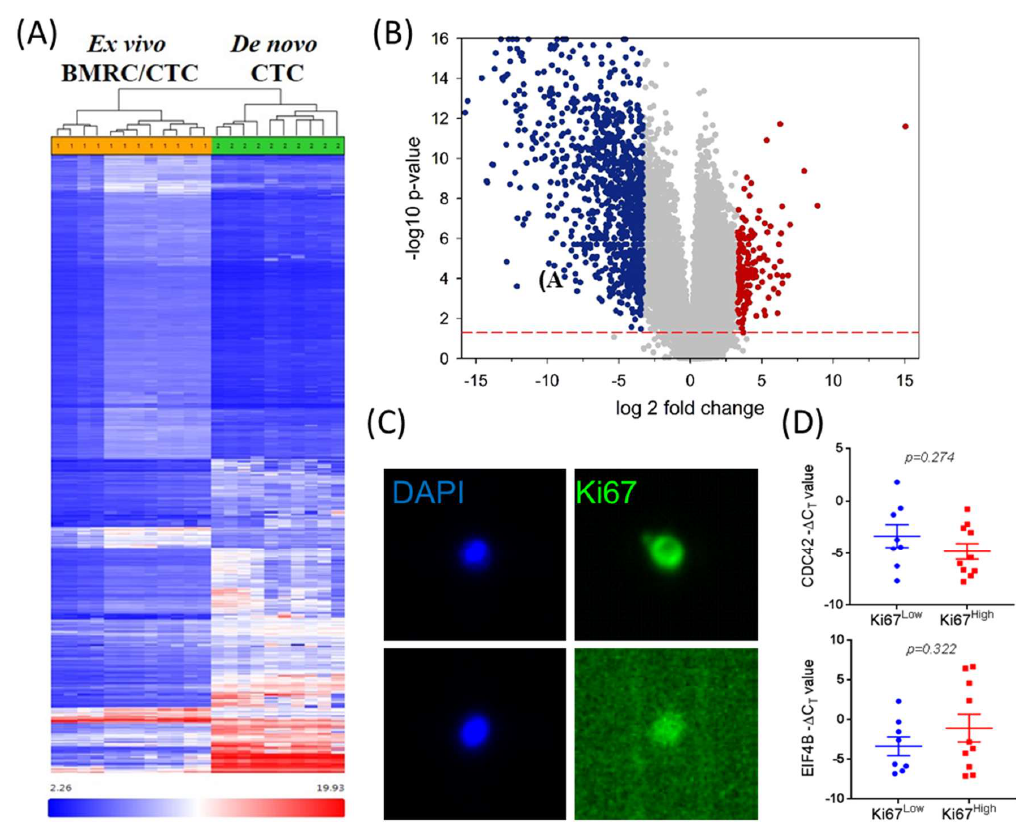
Figure 5. The comprehensive transcriptomic analysis of ex vivo BMRC/CTC vs de Novo CTC populations. ( A ) Heat map showing differential gene expression in ex vivo BMRC/CTC populations vs